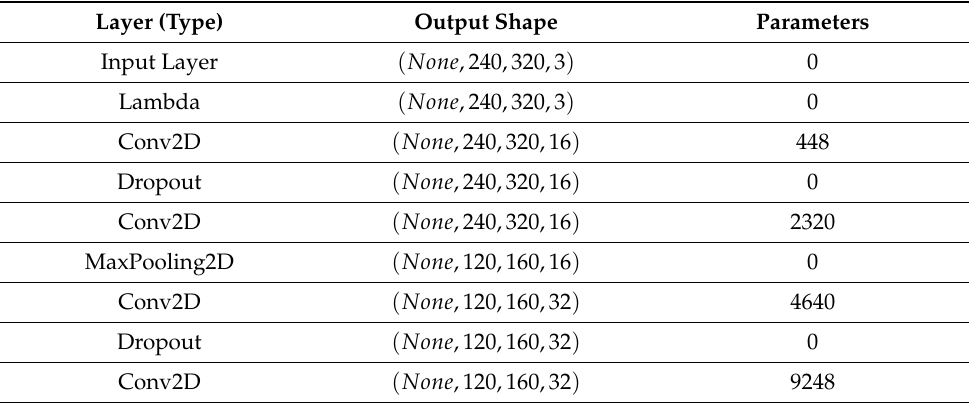
Table 2. Architecture of the